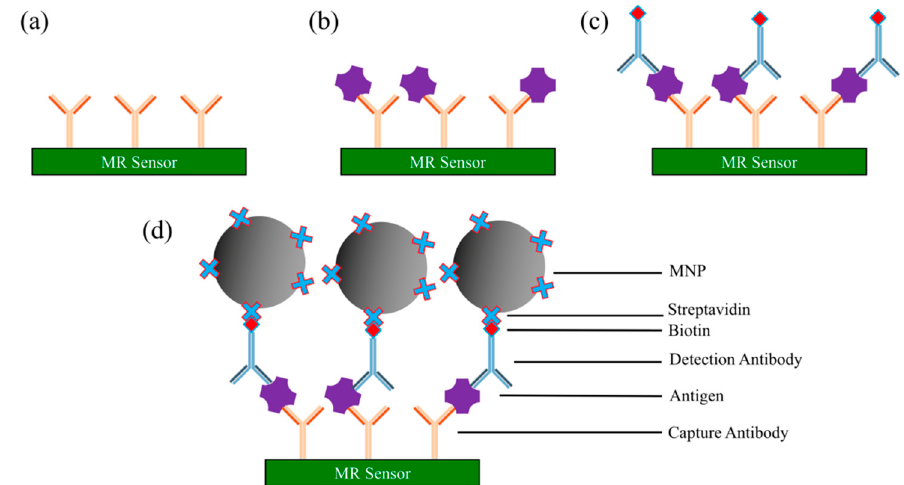
Figure 5. Schematic view of a MR sensor-based sandwich assay. ( a ) MR sensor surface coated with capture antibodies; ( b ) biological sample is loaded onto sensor surface, and antigens of interest specifically bind to capture antibodies; ( c ) biotinylated detection antibodies are added and specifically bind to antigens; ( d ) streptavidin-linked magnetic nanoparticles (MNPs) are added and bind to detection antibodies through biotin-streptavidin conjugation.